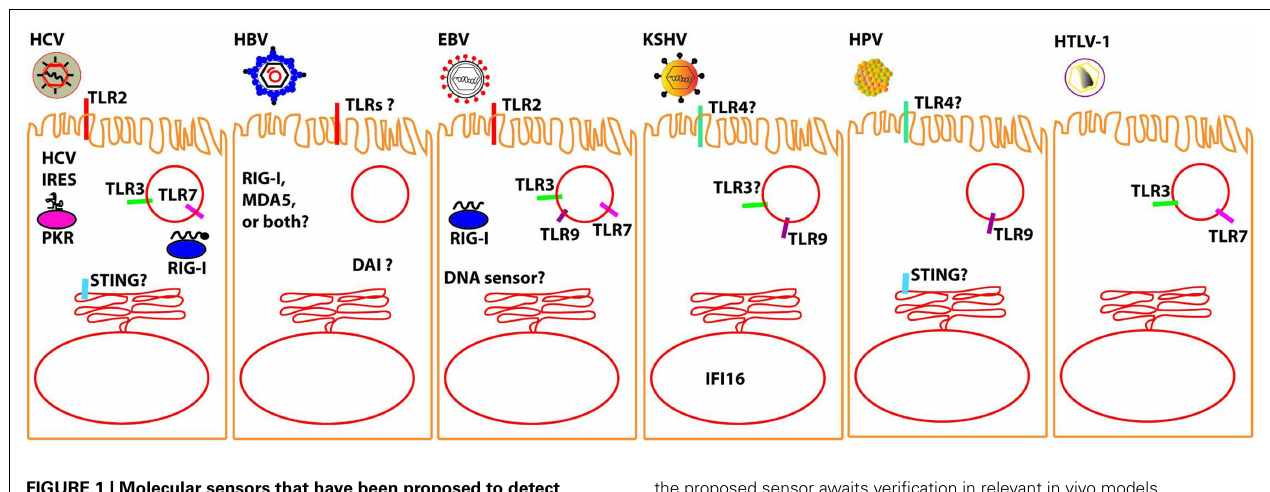
FIGURE 1 | Molecular sensors that have been proposed to detect oncolytic viruses (to the best of our knowledge, no sensor has been yet definitively shown for MCPyV) . It should be noted that most of the interactions between the described oncolytic viruses and